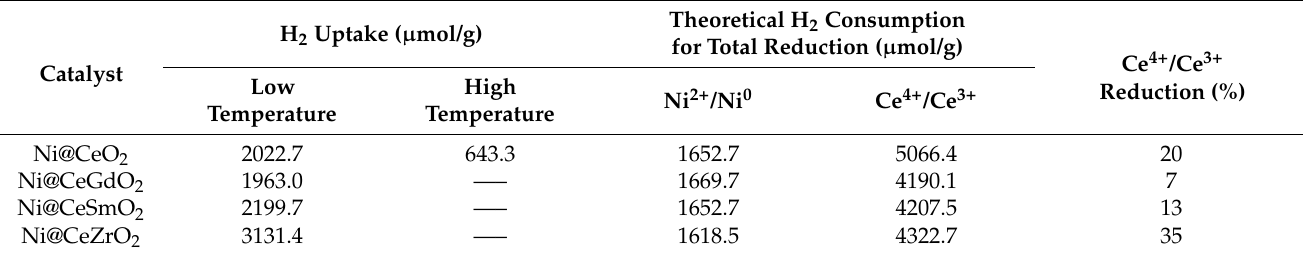
Table 3. H 2 uptake and CeO 2 reduction degree calculated from